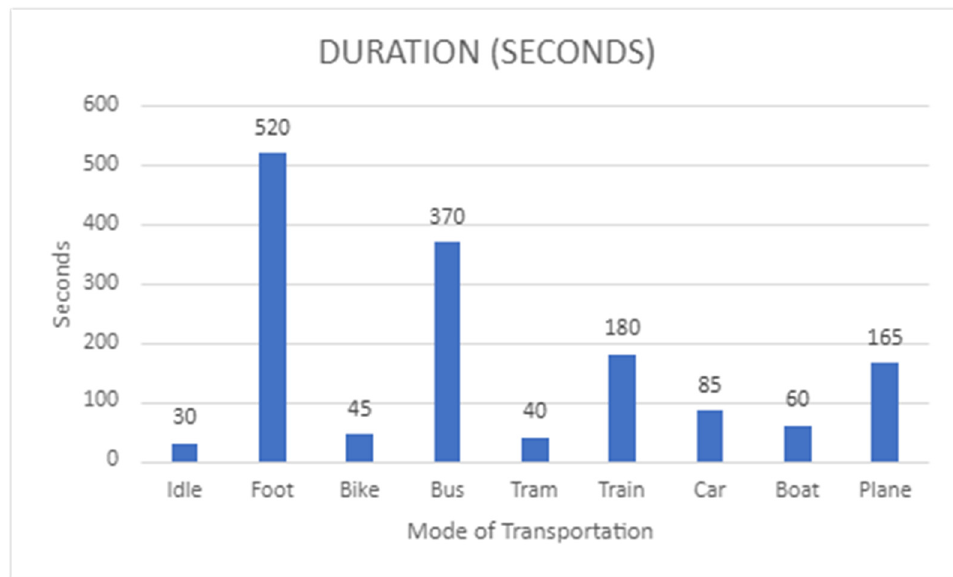
Figure 14. Transportation detection for foot, bus, and train (total of 1 h).